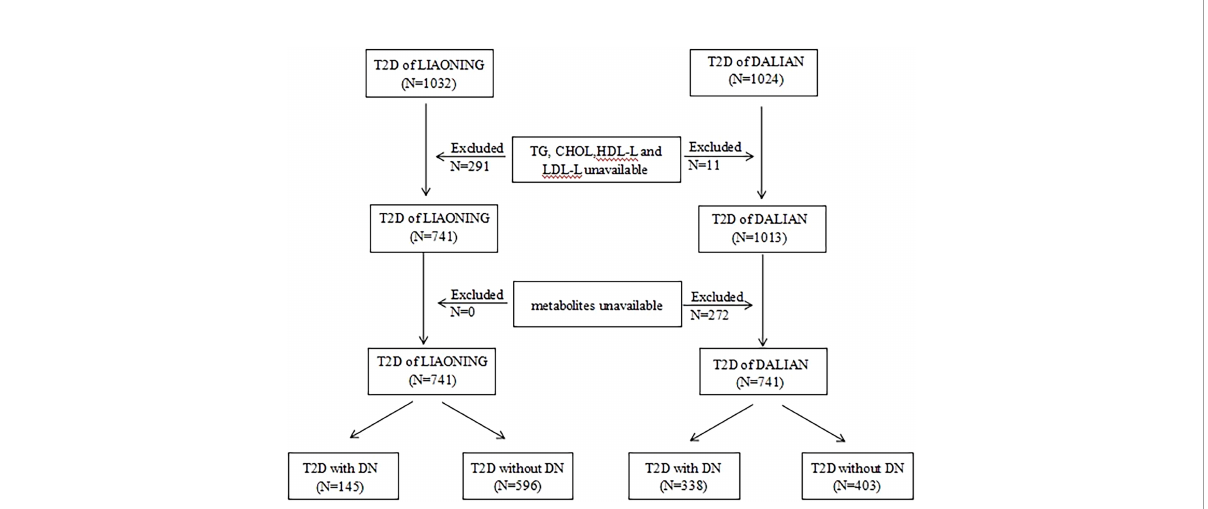
FIGURE 1 Flow chart of selection of participant in this study. T2D, type 2 diabetics; LMUFAH, Liaoning Medical University First Af fi liated Hospital; DALIAN, Second Af fi liated Hospital of Dalian Medical University; TG, triglyceride; CHOL, cholesterol; HDL-C, high-density lipoprotein cholesterol; LDL-C, low-density lipoprotein cholesterol; DN, diabetic